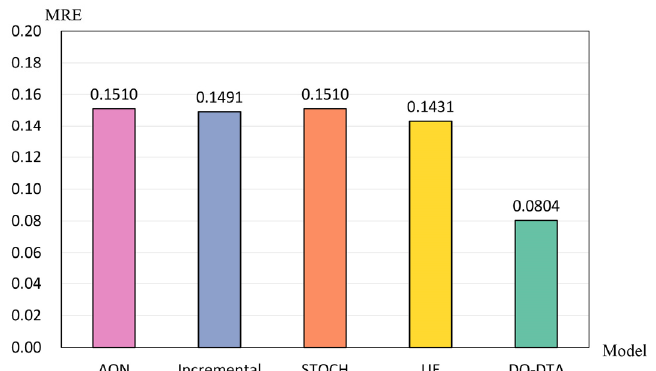
Figure 5. The mean relative error of observed links of the four classical models and the DQ-DTA model on the expressway network.